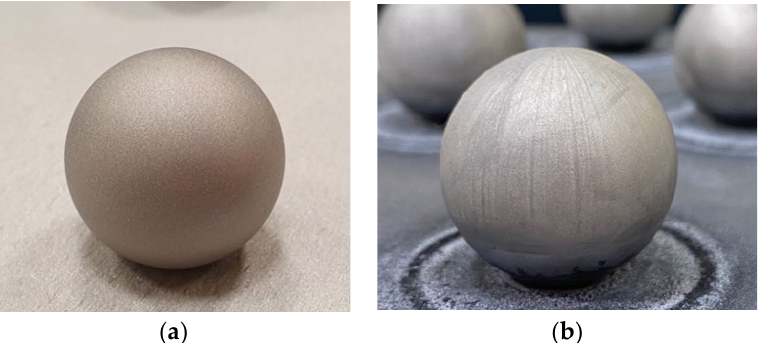
Figure 6. ( a ) Surface finish after sandblasting (previous research). ( b ) Surface finish after chemical treatment with aqua regia.